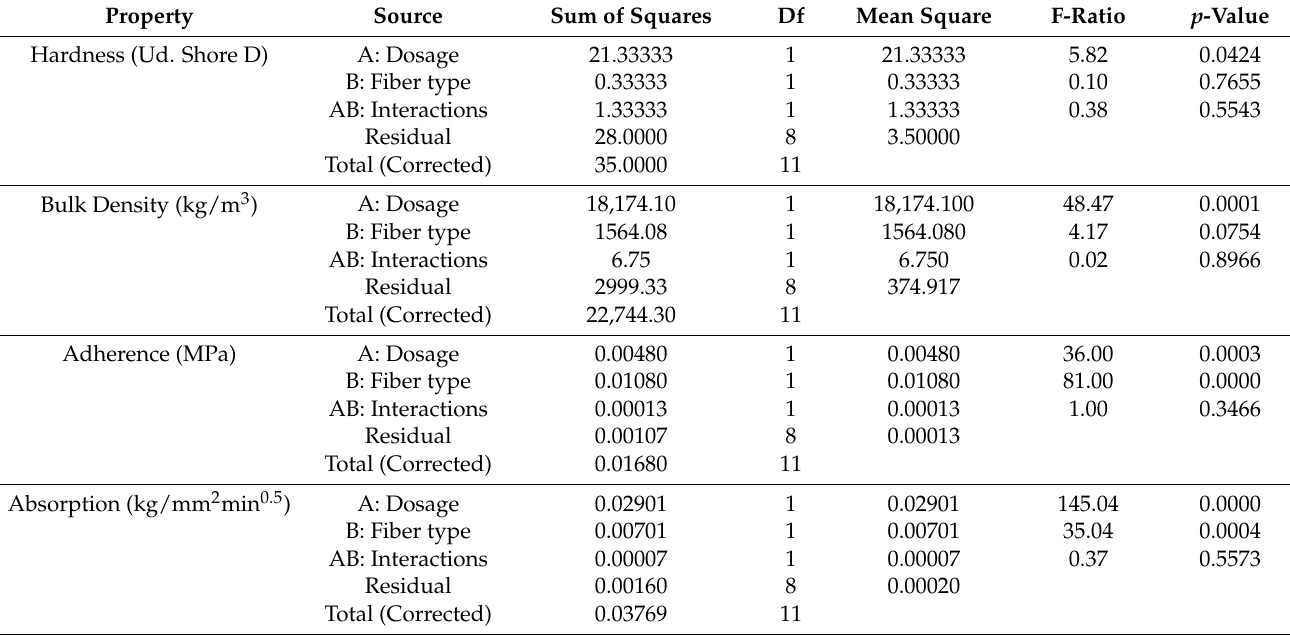
Table 11. Analysis of variance (ANOVA) for flexural and compressive mechanical